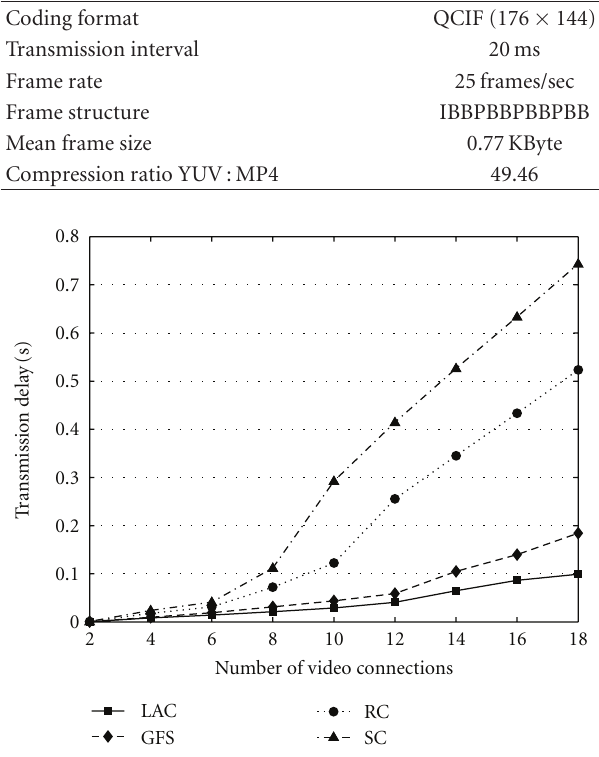
Figure 7: Average end-to-end delay with video tra ffi